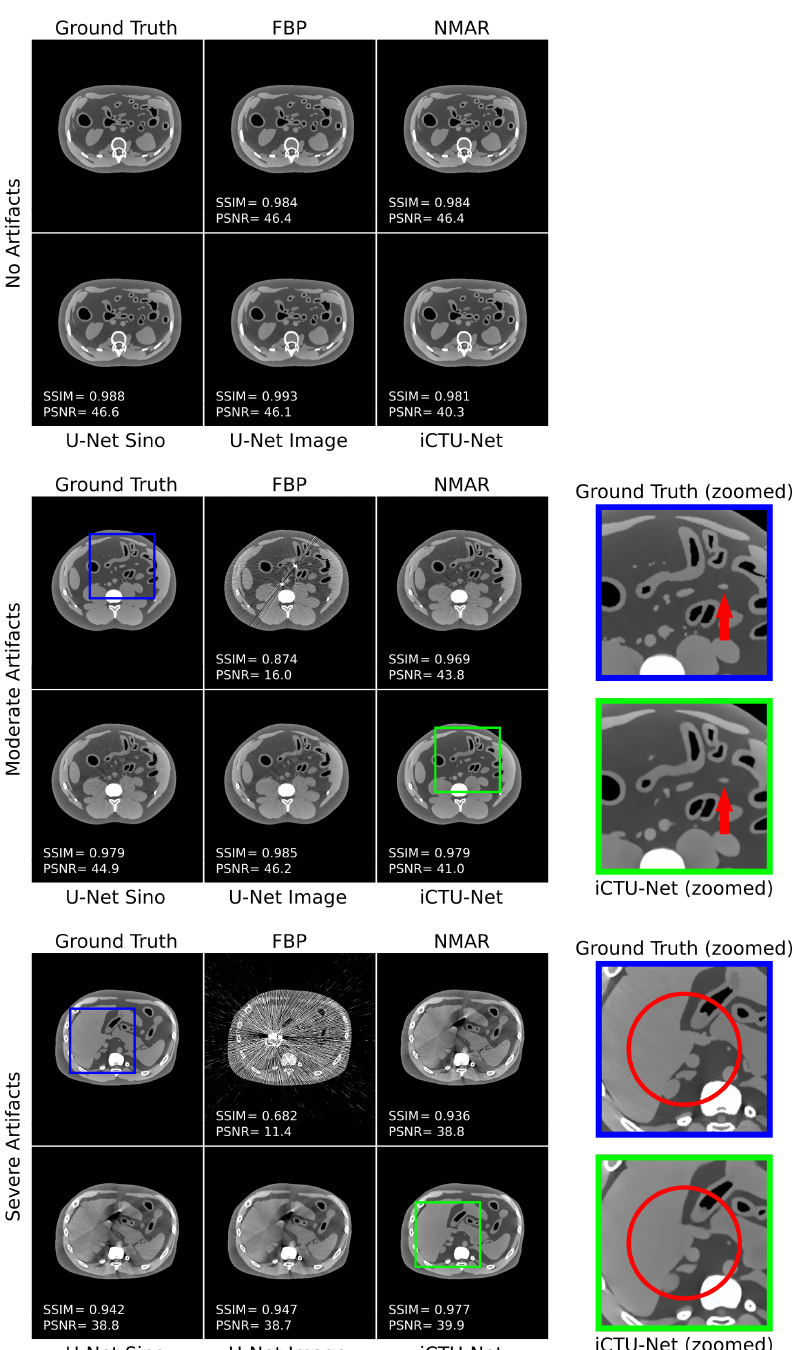
Figure 6. Results of the comparison study, where the ground truth and FBP are compared to NMAR, U-Net Sino, U-Net Image, and iCTU-Net. A slice without metal artifacts, with moderate metal artifacts, and with severe metal artifacts is shown. The scans are windowed to [ − 300 HU, 300 HU] to increase the visibility of the artifacts. The arrows and circles in the zoomed images indicate anatomies that could only be recovered by the